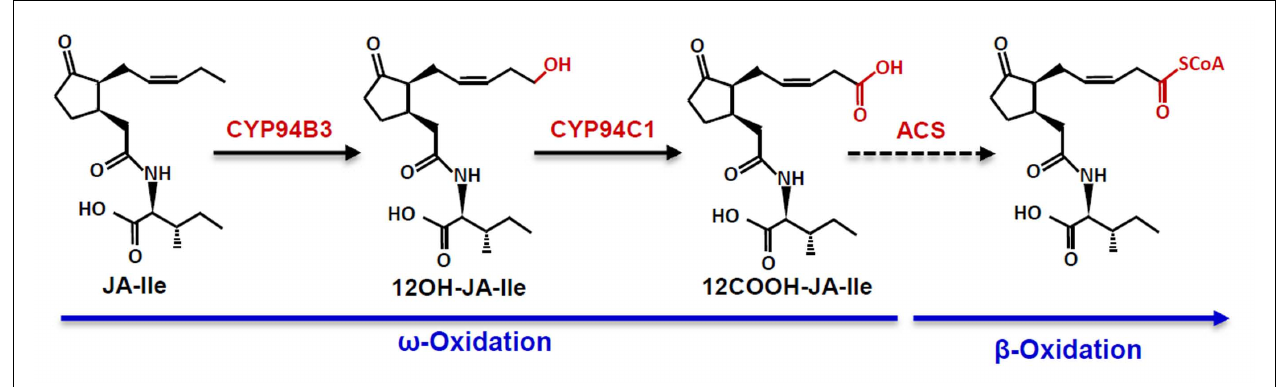
FIGURE 2 |The CYP94-mediated ω -oxidation pathway for JA-Ile catabolism. The dashed line denoting formation of the CoA ester of 12COOH-JA-Ile by an acyl-CoA synthetase (ACS) is